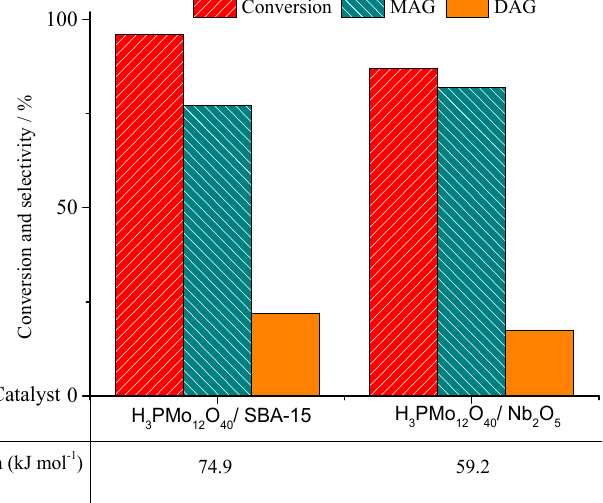
Figure 11. Conversion and selectivity of H 3 PMo 12 O 40 /SBA − 15 or H 3 PMo 12 O 40 /Nb 2 O 5 − catalyzed reactions of glycerol esterification with HOAc (adapted from ref. [52]). Reaction conditions: glycerol: HOAc molar ratio (1:6); catalyst load (5 wt.%); time (8 h); temperature (353 K).